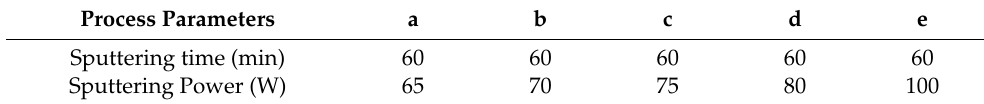
Table 2. Process parameters used in sputter